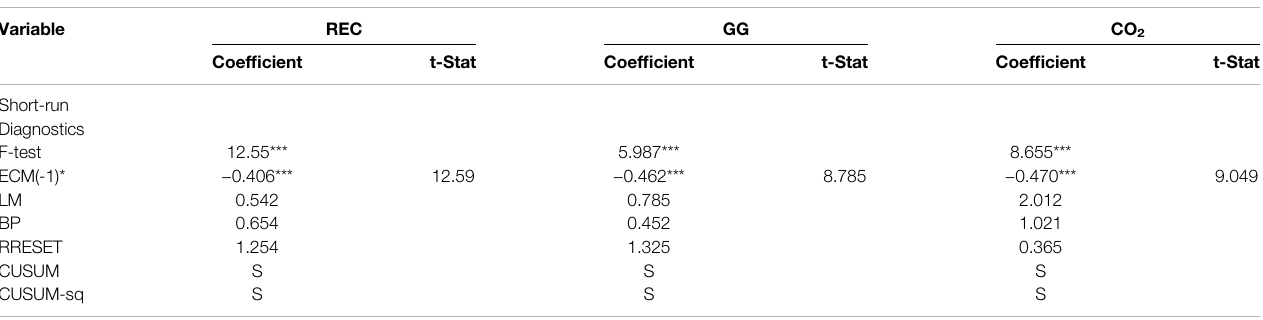
TABLE 4 | Short and long-run estimates of renewable energy consumption, green growth, and CO 2 emissions. Variable